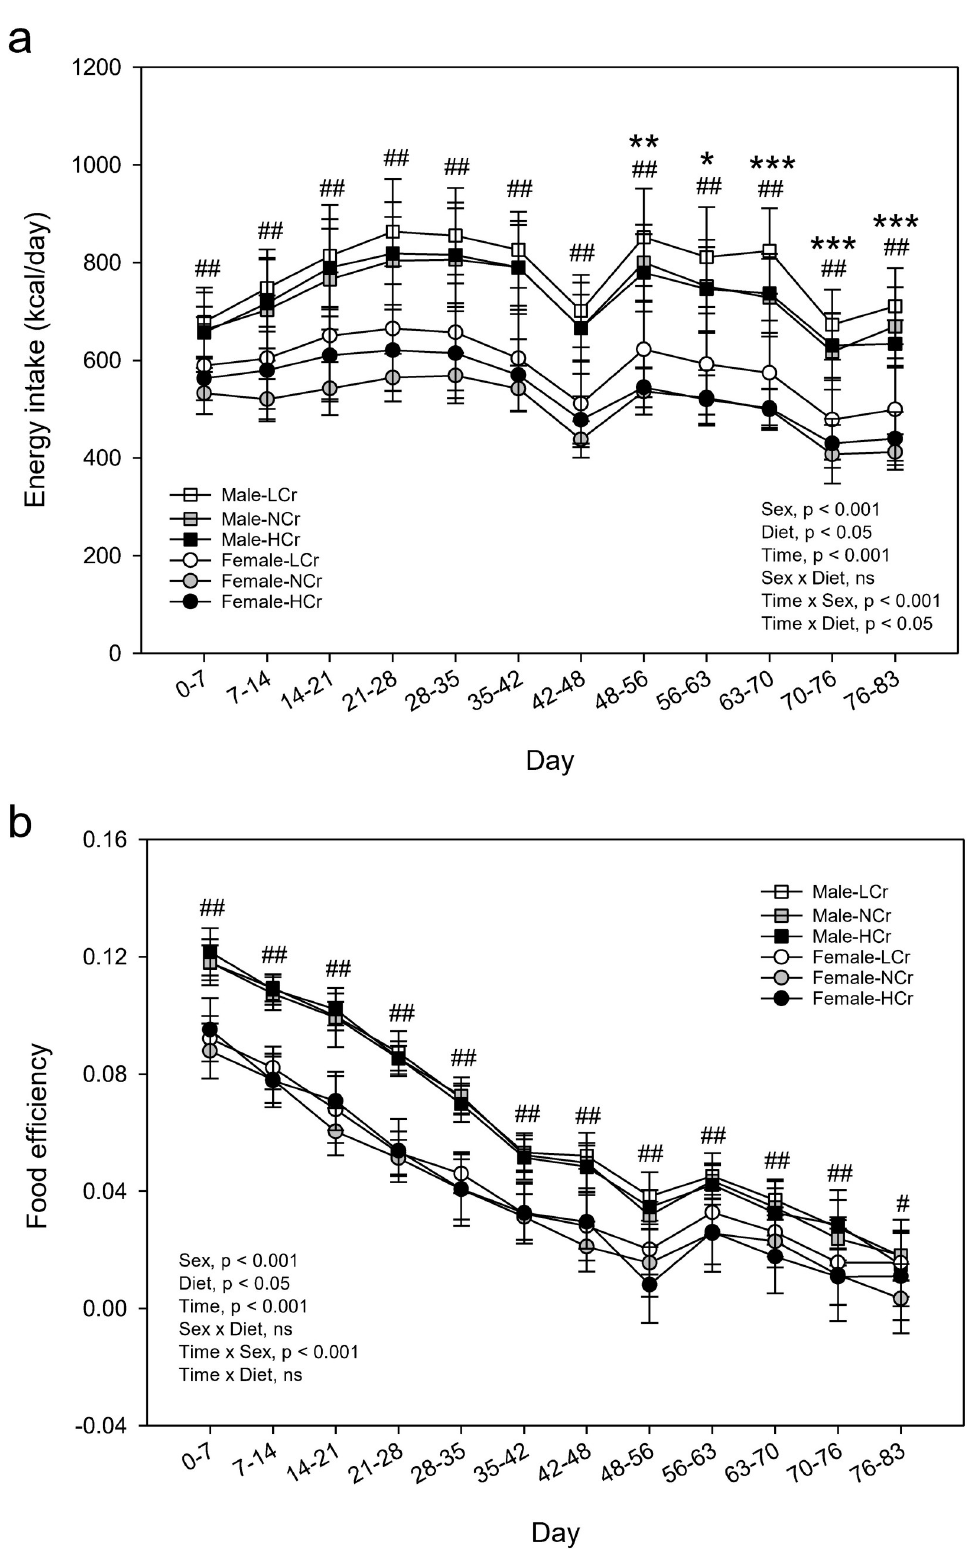
Fig 2. Energy intake and food efficiency of male and female rats. Results are presented as means ± SD, n = 9 − 10. Results for energy intake (a) and food efficiency (b) were analyzed by mixed-design ANOVA to determine effects and